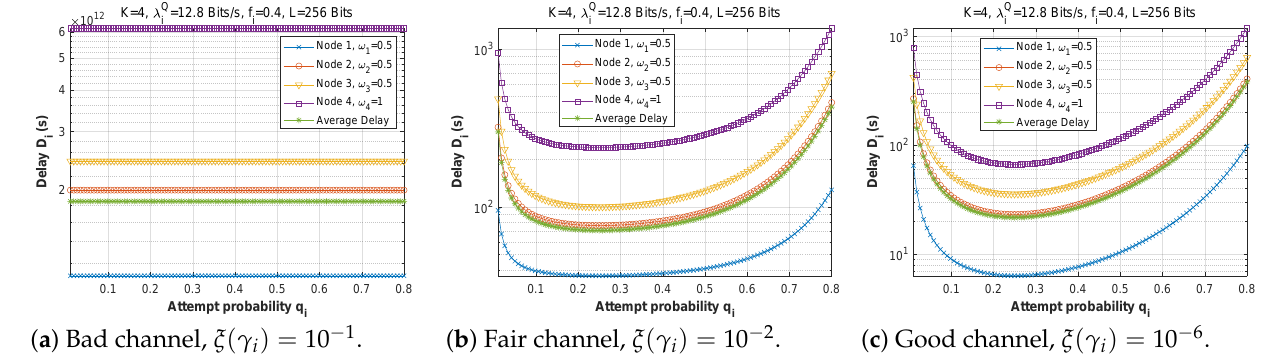
Figure 12. Setting 1: The delay experienced at each mobile device when varying the attempt probability with the bit error rate ξ ( γ i ) .